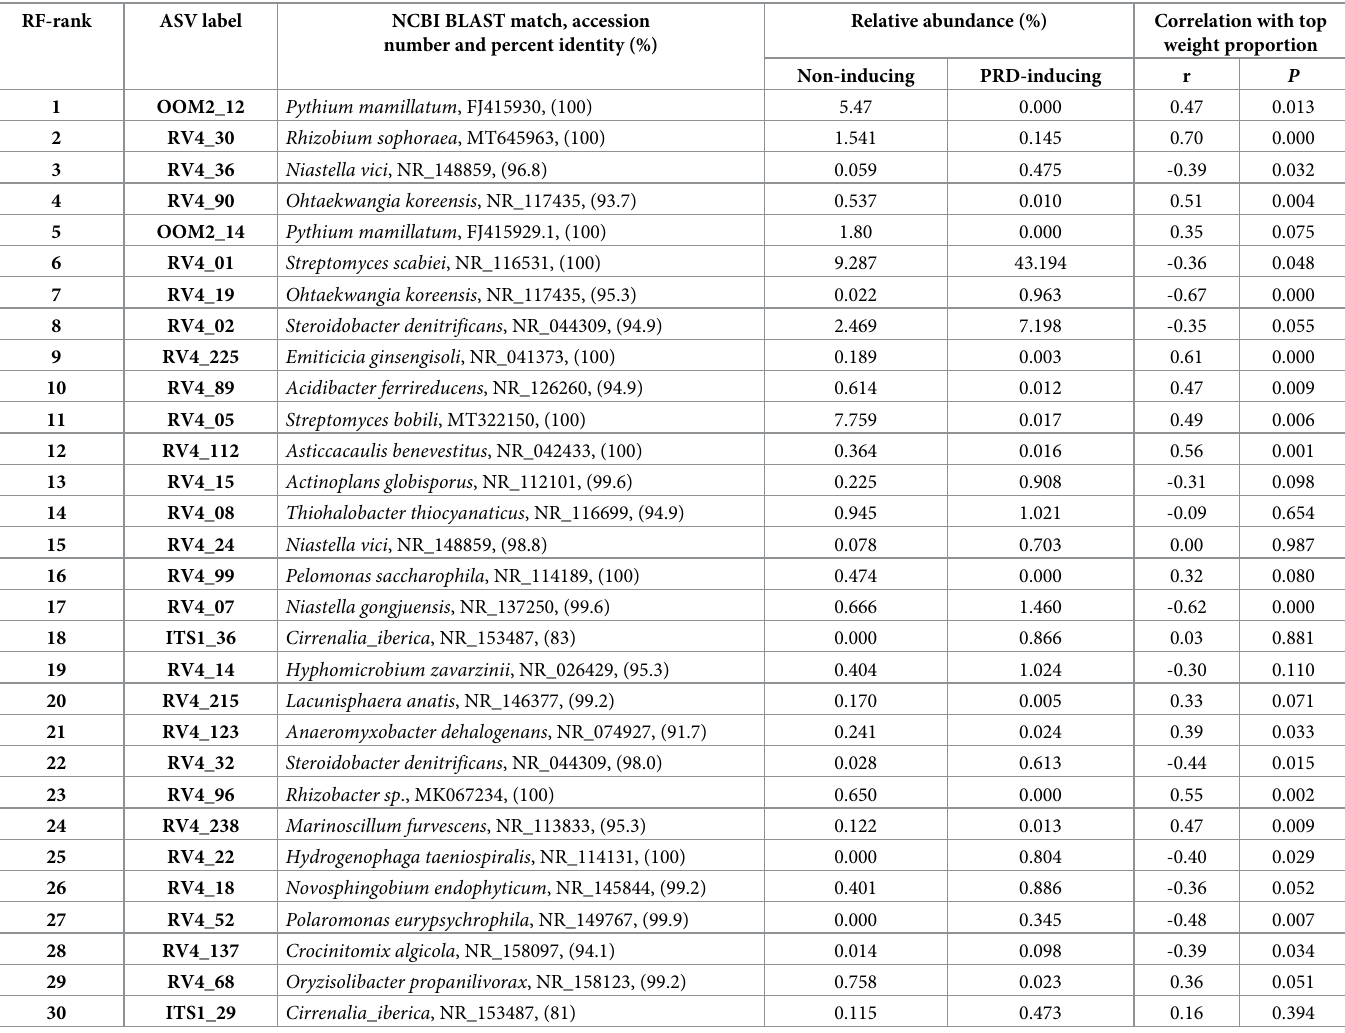
Table 5. Identities, relative abundances, and relationships to control proportions of top weight among top-30 RF classification model of PRD predictors a